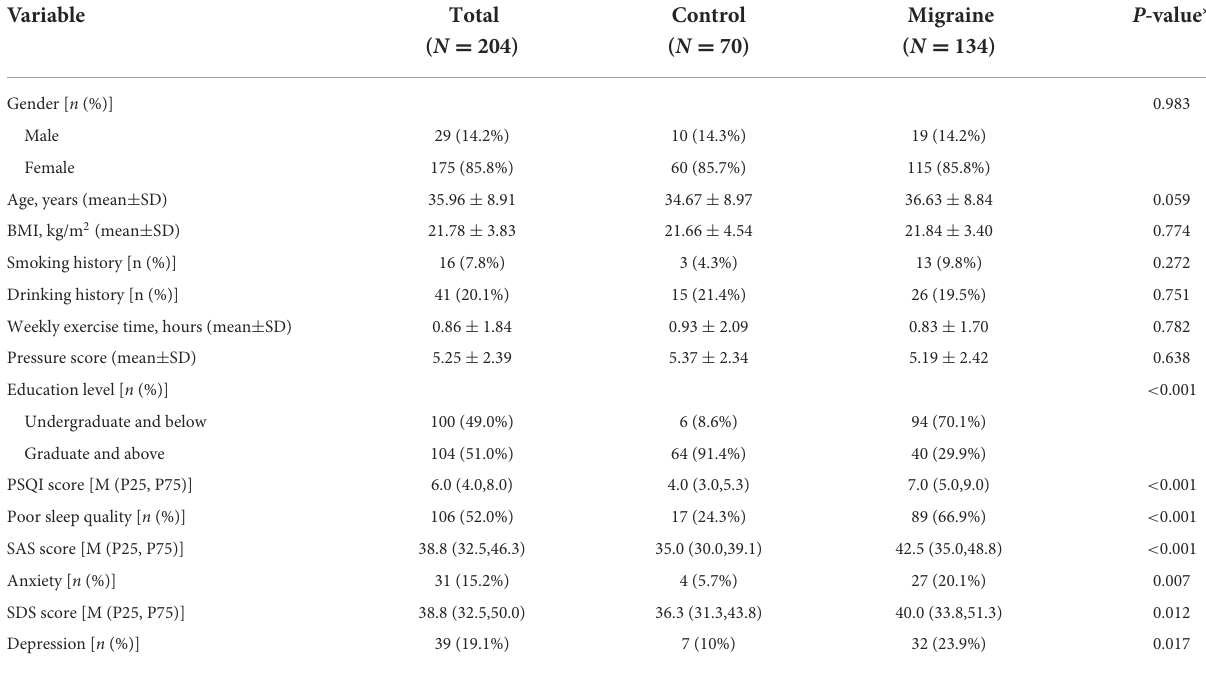
TABLE 1 Baseline characteristics of migraine and control groups.